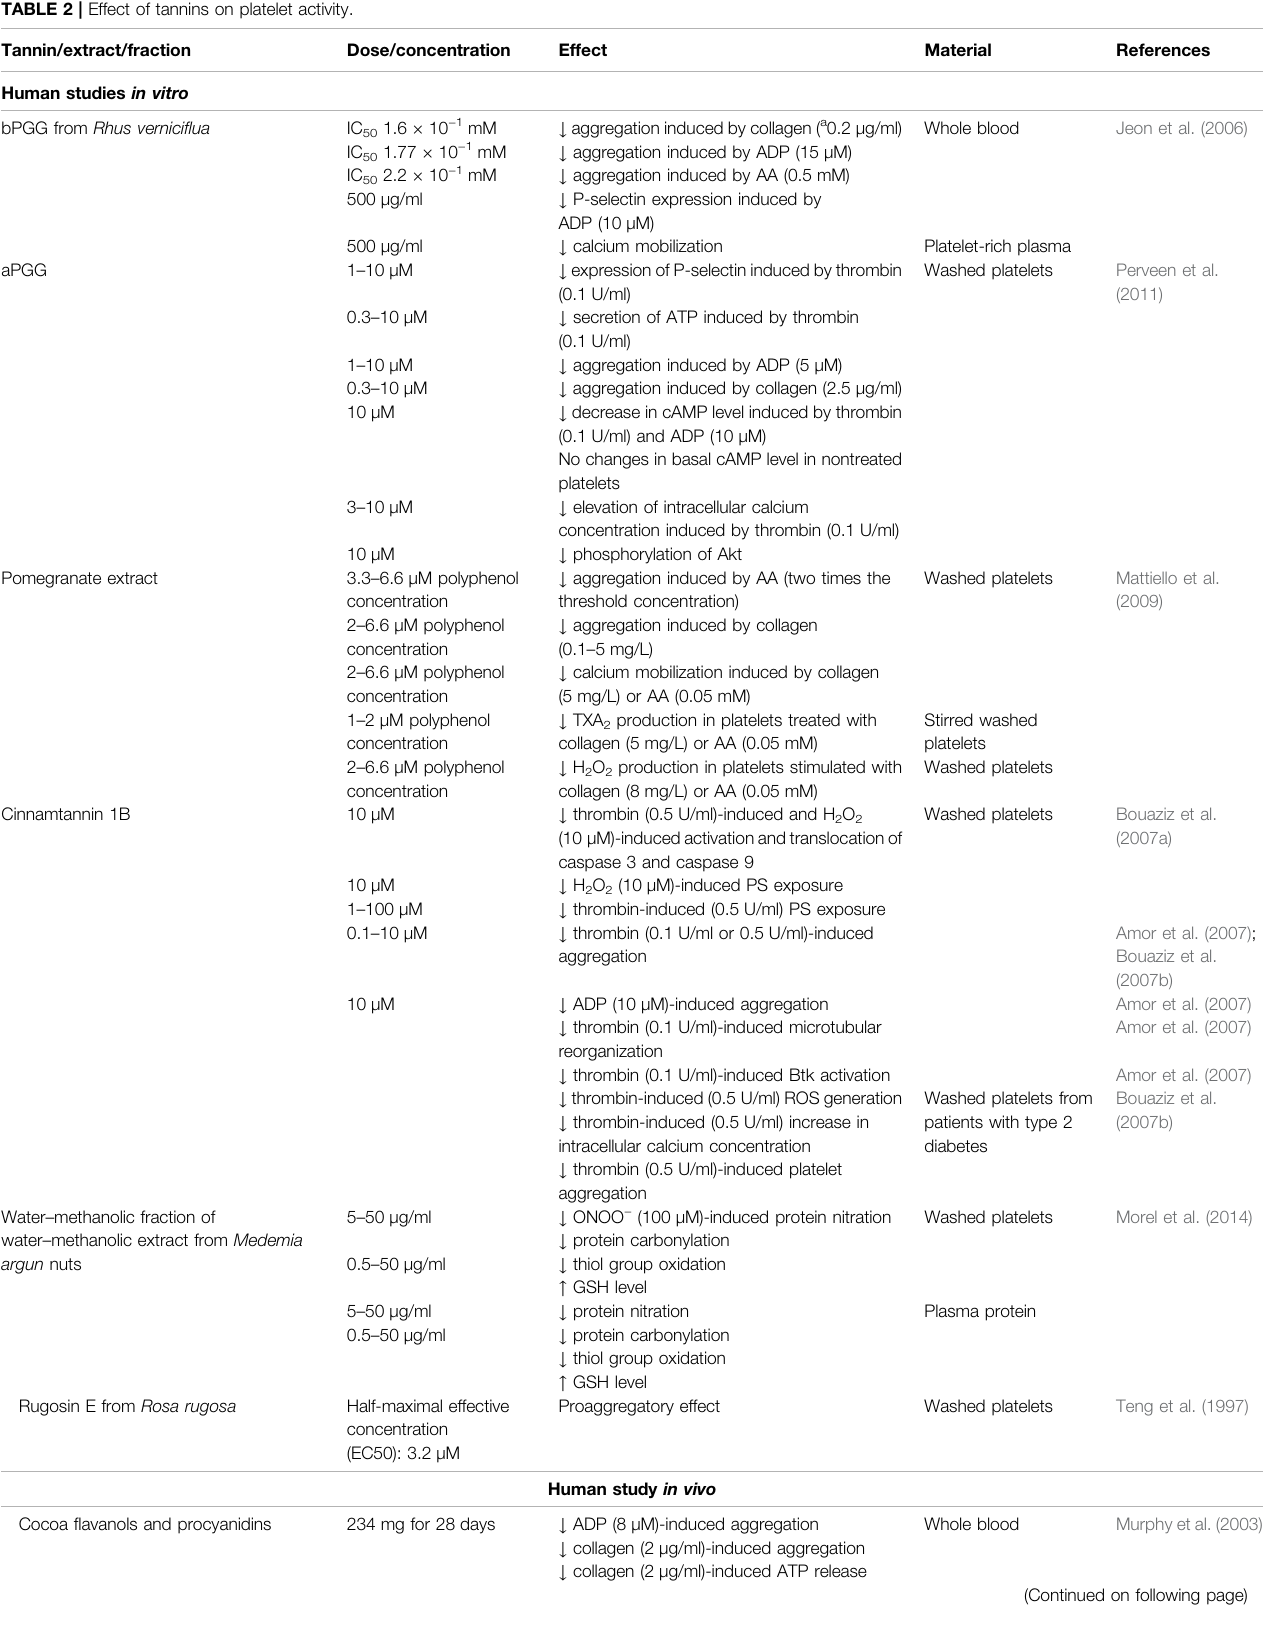
TABLE 2 | Effect of tannins on platelet